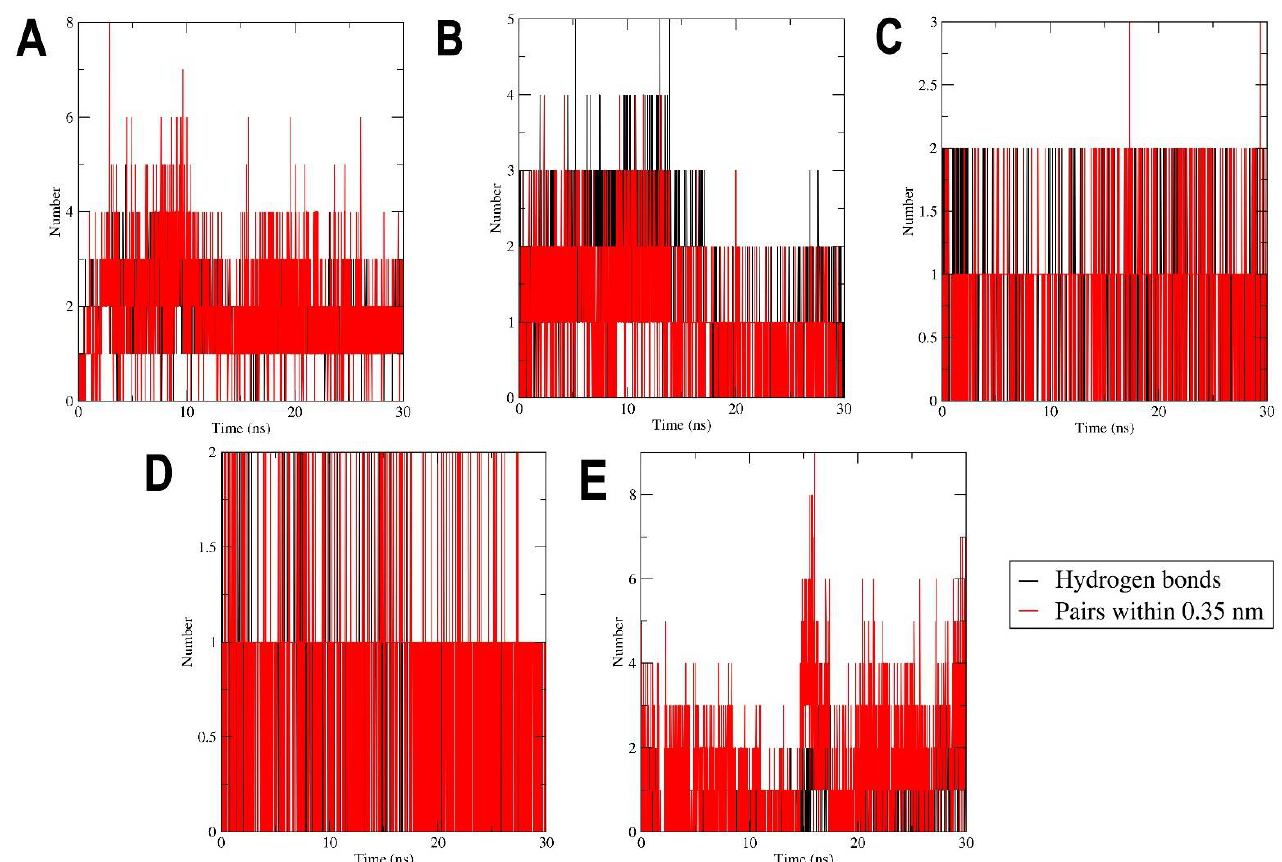
Figure 6. Time evolution of number of hydrogen bonds formed between MEK1 and the compounds. ( A ) 129696793, ( B ) 10813589, ( C ) 10991656, ( D ) 10524567, and ( E ) 10575055.